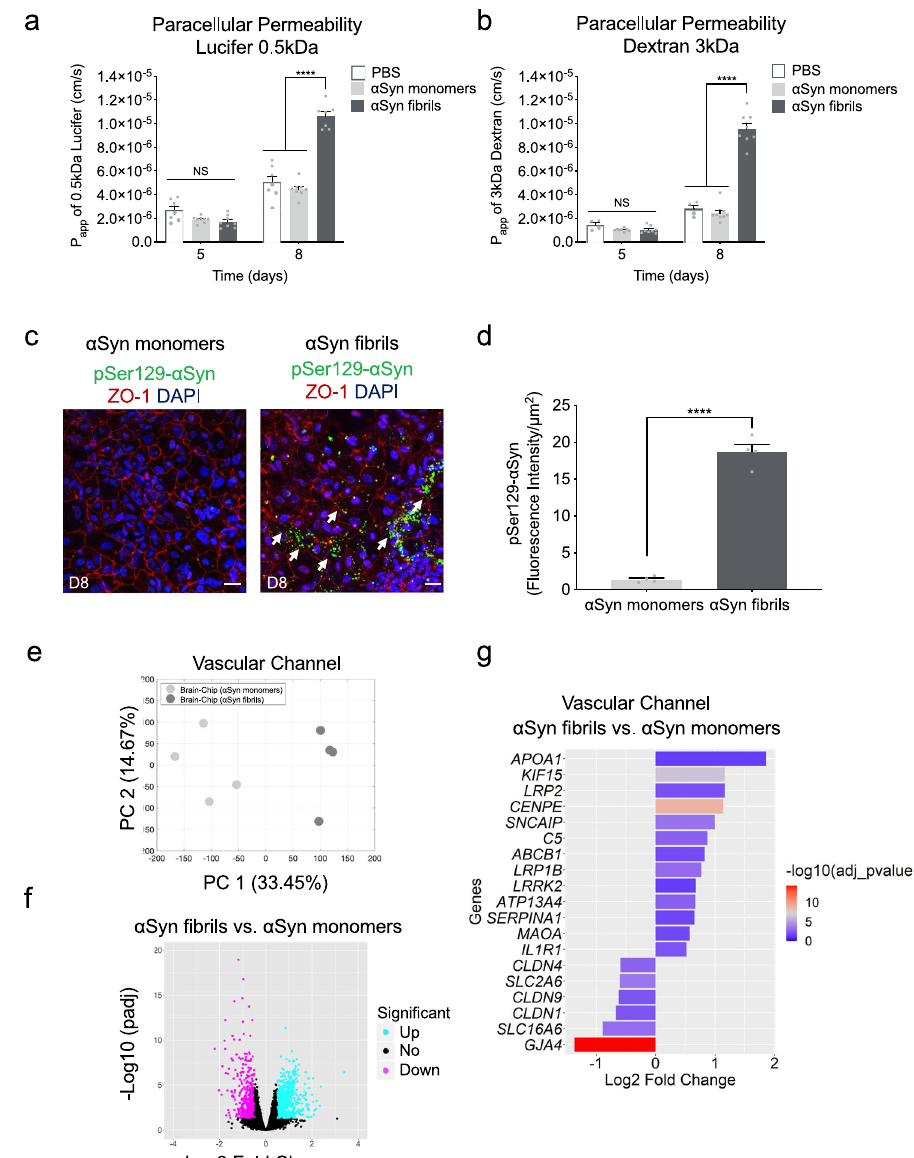
Fig. 6 Blood-brain barrier dysfunction in the α Syn fi bril model. a , b Quantitative barrier function analysis via permeability to 0.5 kDa lucifer yellow and 3 kDa fl uorescent dextran at day 5 and 8 following exposure to α Syn fi brils or α Syn monomers. Statistical analysis is two-way ANOVA with Tukey ’ s multiple comparisons test ( n = 6 – 9 independent chips, **** P < 0.0001 compared to monomeric group, NS not signi fi cant). Error bars represent mean ± SEM. c Immuno fl uorescence micrographs show accumulation of phosphorylated α Syn (green, phospho- α Syn129 staining; red, ZO-1; blue, DAPI) in the vascular channel of the Brain-Chip (white arrow), following treatment with α Syn fi brils, in contrast to lack of detected pathology in response to α Syn monomers. Scale bars: 100 μ m. d Quantitative analysis of fl uorescence intensity in each group at day 6 post exposure to α Syn fi brils or α Syn monomers. Statistical analysis is two-sided unpaired t -test ( n = 4 independent chips with 3 – 5 randomly selected different areas per chip, **** P < 0.0001 compared to monomeric group). Error bars represent mean ± SEM. e Principal component analysis (PCA) generated using the RNA-seq data generated by the samples collected from the vascular channel of the Substantia Nigra Brain-Chip upon exposure to α Syn monomers or α Syn fi brils ( n = 4 per condition). A 2D- principal component (PC) plot is shown with the fi rst component along the X -axis and the second along the Y -axis. The proportion of explained variance is shown for each component. f The volcano plot shows the differentially expressed (DE) genes between α Syn fi brils and α Syn monomers, as identi fi ed by the RNA-sequencing analysis. For the selection of the DE genes we used the following thresholds: adjusted (adj) p -value < 0.05 and |Log2(foldchange)| > 0.5. The identi fi ed up- (down-) regulated genes are highlighted in cyan (magenta) color. Sample sizes were as follows: Brain-Chip ( α Syn monomers), n = 4, Brain-Chip ( α Syn fi brils), n = 4. The p -values attained by the two-sided Wald test and corrected for multiple testing using the Benjamini and Hochberg method. g A selection from the 739 upregulated and 541 downregulated genes identi fi ed after performing differentially gene expression (DGE) analysis between α Syn fi brils and α Syn monomers. The size of the bars indicates the log2(Fold-Change) of the corresponding gene expressions and the colors the statistical signi fi cance (False Discovery Rate; FDR adjusted (adj) p -value < 0.05) of the corresponding changes. Statistical analysis is two-sided Wald test and corrected for multiple testing using the Benjamini and Hochberg